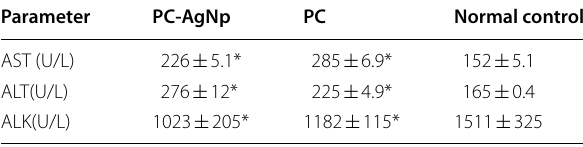
Table 3 Comparison of liver enzymes (AST, ALT, ALK) in control, PC consuming group and PC-AgNp consuming groups of rats